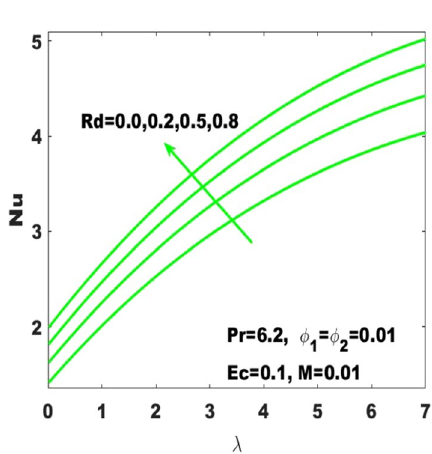
Figure 4. Change in Nu with (cid:31) for diverse values of Rd